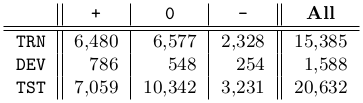
Table from the paper: Lexicon Integrated CNN Models with Attention for Sentiment Analysis
Table text:
+
0
-
All
TRN
6,480
6,577
2,328
15,385
DEV
786
548
254
1,588
TST
7,059
10,342
3,231
20,632